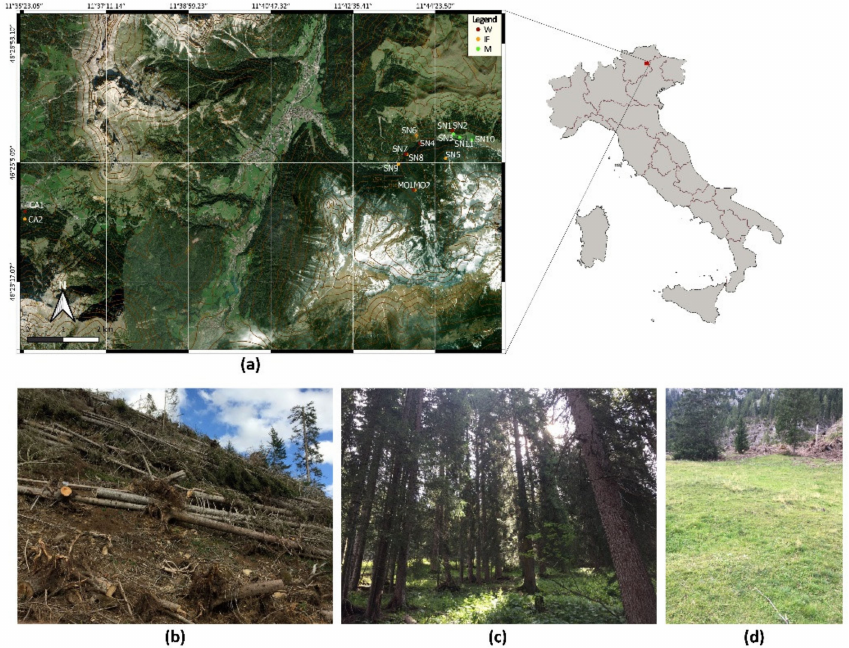
Figure 1. Study area location, with: ( a ) distribution of the 15 sites across the three localities (CA: Carezza, MO: Val Monzoni, SN: Val San Nicol ò ) [28]; photos indicative of the three conditions: ( b ) windthrow and ( c ) intact forest, and ( d ) meadow (SN2, CA2, and SN3,